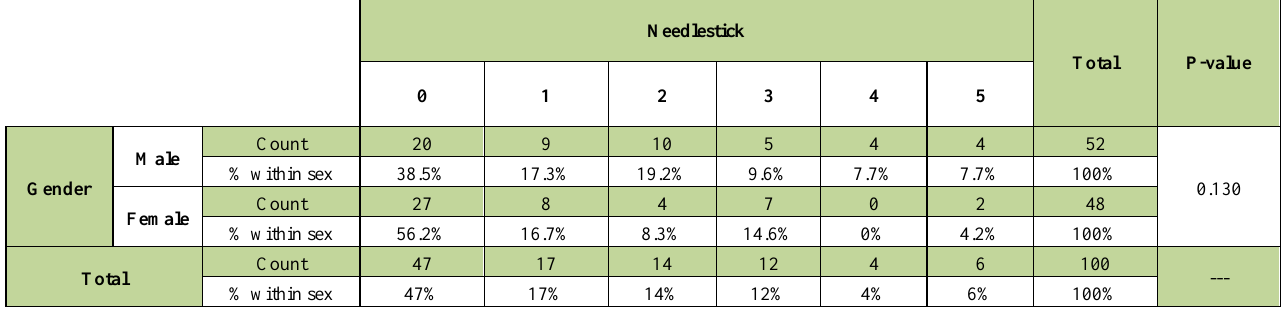
Table 6. Frequency of samples in terms of the number of needle sticks by gender.